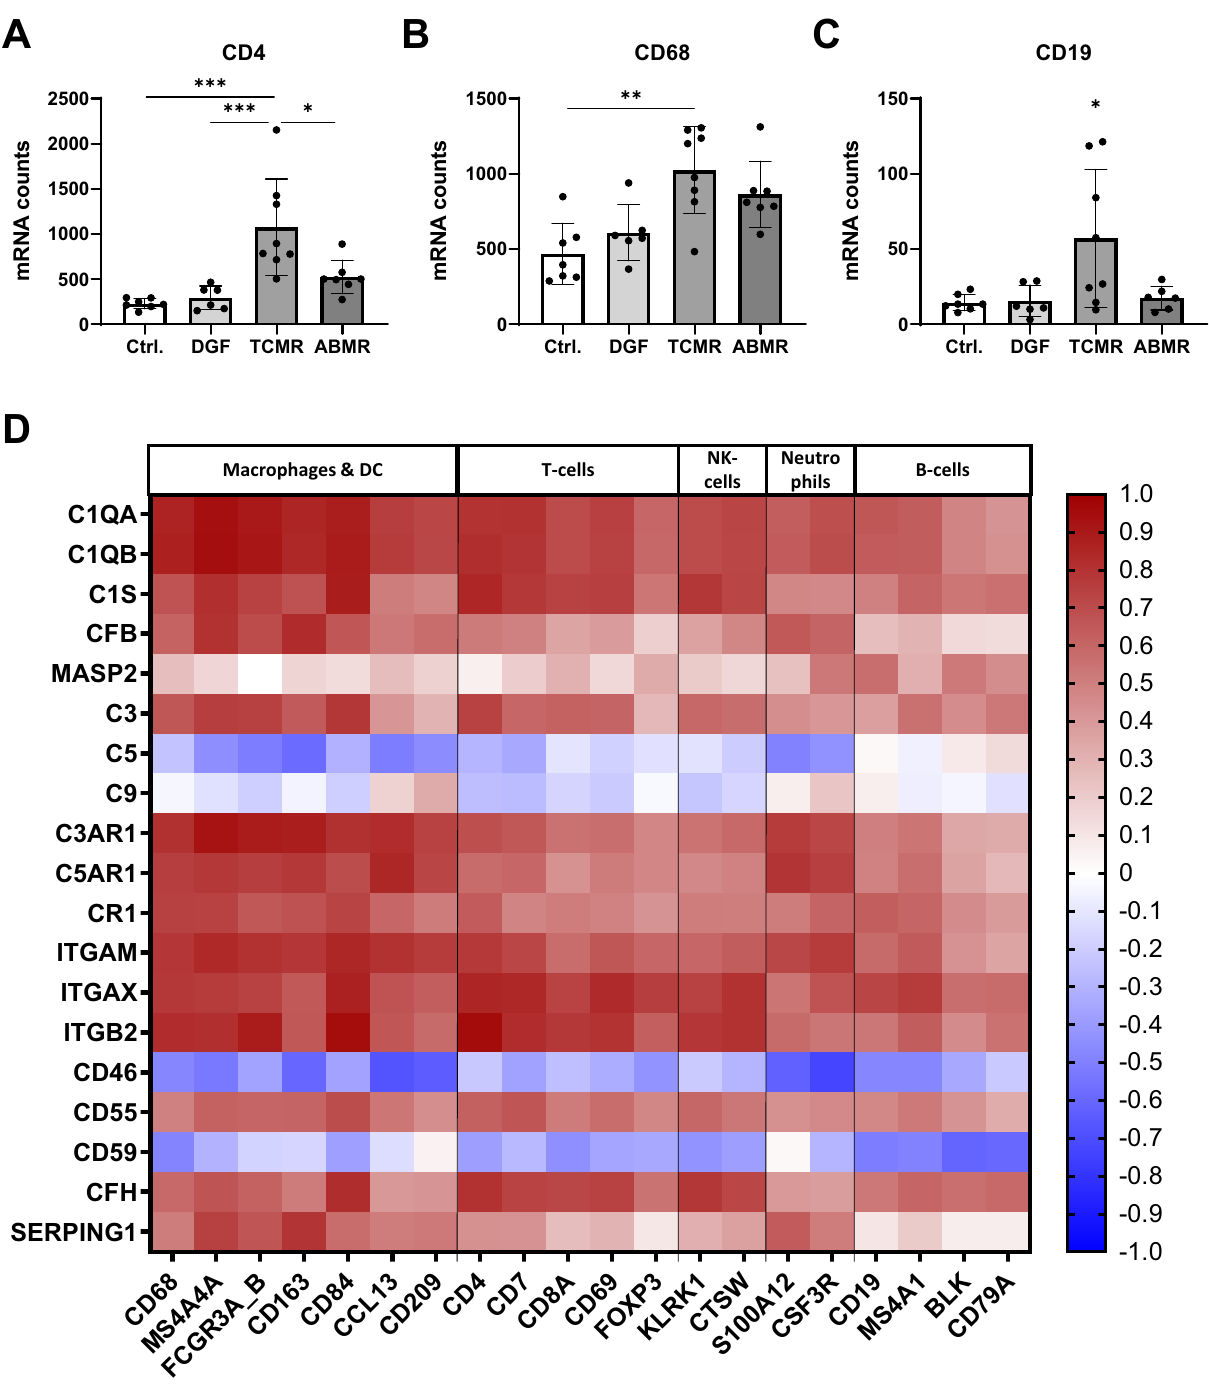
Figure 4. Expression analysis of immune cells. Number of mRNA molecules coding for T-lymphocyte ( A ), macrophage ( B ) and B-lymphocyte ( C , ABMR n = 6) markers in follow-up biopsies of renal transplants with no rejection (Ctrl), delayed graft function (DGF), T-cell mediated rejection (TCMR) or antibody mediated rejection (ABMR); (Statistical analysis: A , C : ANOVA with Tukey’s; B : Kruskal–Wallis with Dunn’s;*p < 0.05; **p < 0.01; ***p < 0.001). ( D ) Heatmap showing correlation of complement gene expression with the expression of genes specific for macrophages, T-cells, natural killer cells, neutrophils and B-cells; n =